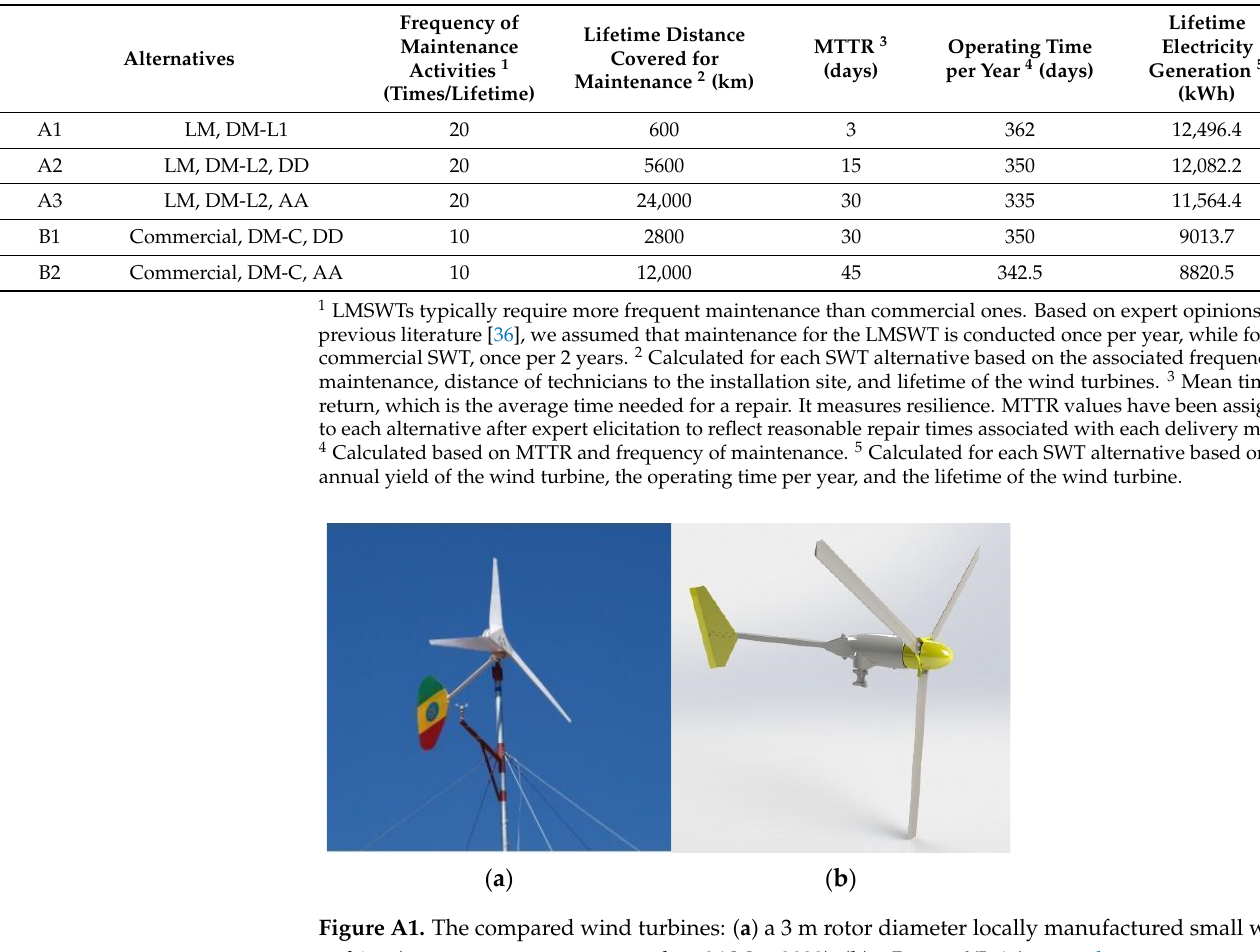
Table A2. Basic parameters for the five SWT alternatives.